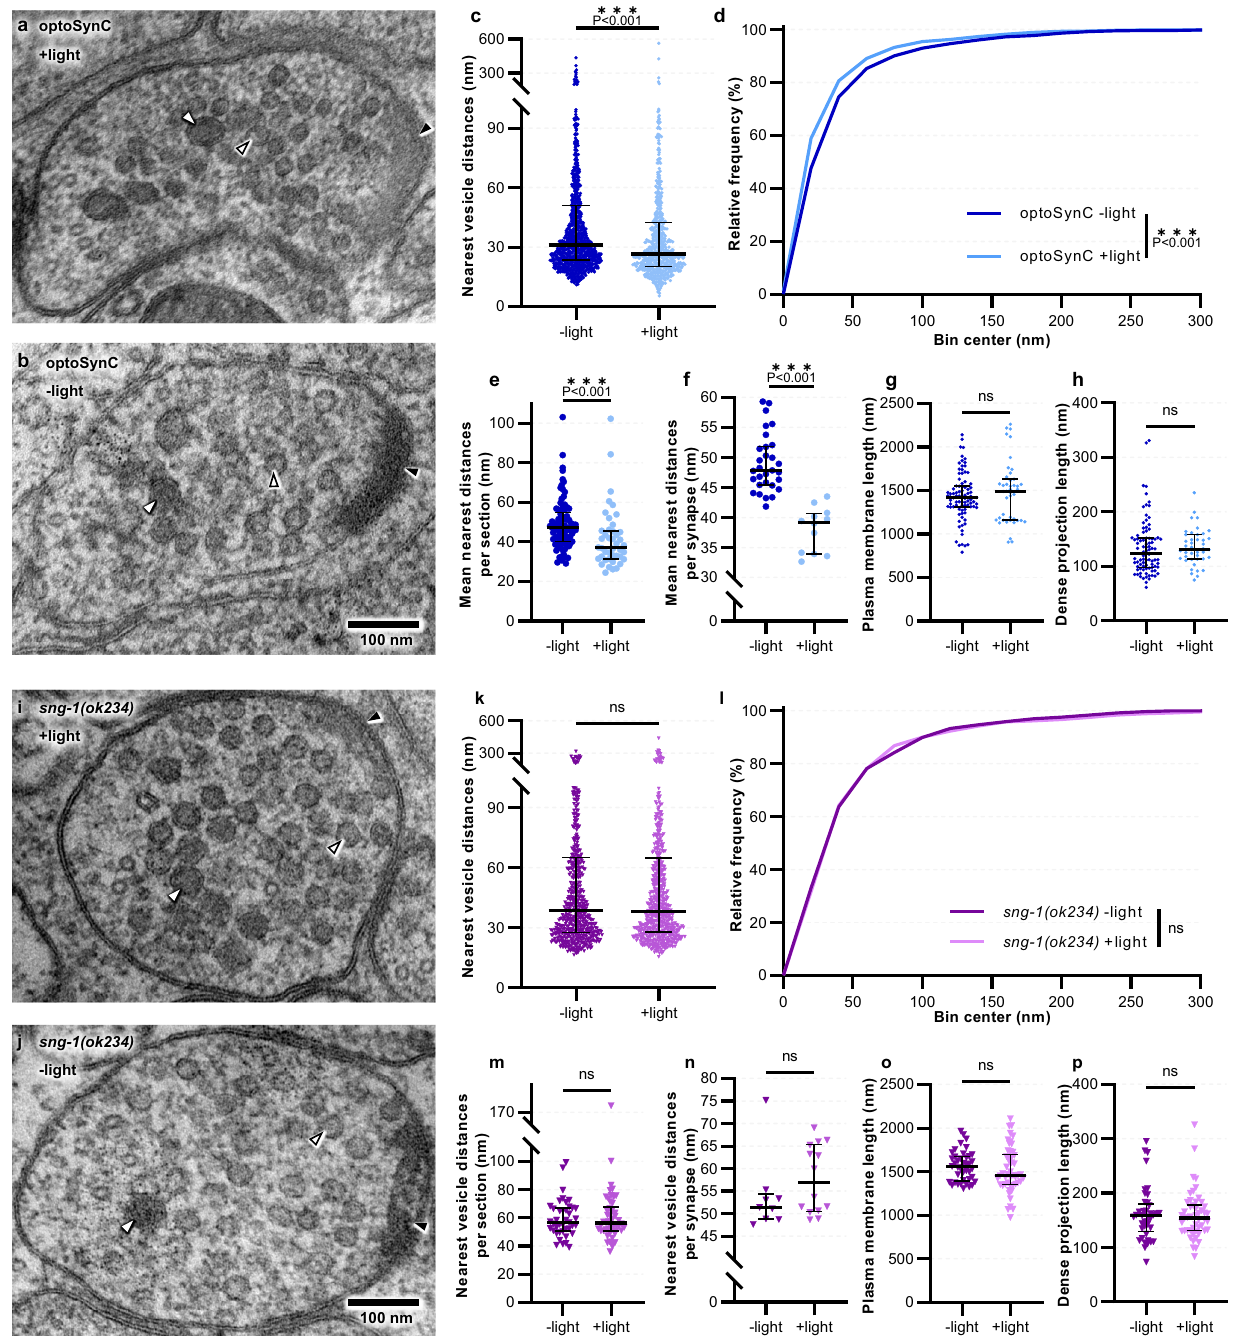
Fig. 4 | optoSynC activation causes clustering of SVs at the ultrastructural level. a , b Transmission electron micrographs of representative cholinergic synapses from animals illuminated for 5s ( a , +light) with blue light (470nm, 0.1mW/mm²), or kept in darkness ( b , − light) before high-pressure freezing. SVs (openblackarrowheads),densecorevesicles(DCVs,whiteclosedarrowheads),and denseprojection(DP,closedblackarrowheads)areindicated. c Distanceanalysisof nearest vesicles for each analyzed cholinergic micrograph; − light ( n =1473), +light ( n =819). d Relative frequency distribution of nearest vesicle distances shown in c . e Meannearestdistancespersection; − light( n =88),+light( n =43). f Meannearest